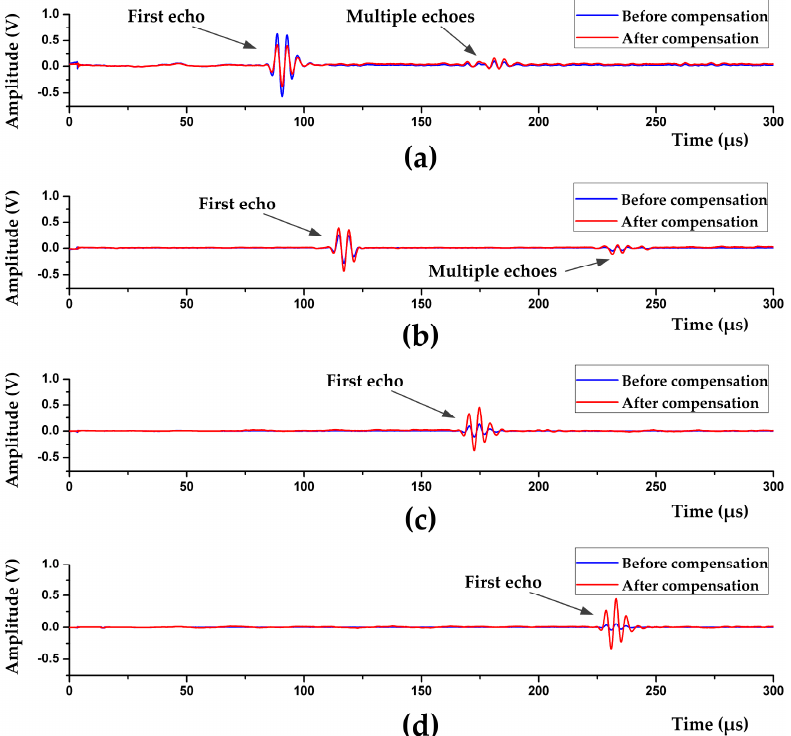
Figure 13. Waveforms of the echo signals reflected by interfaces at different distance: ( a ) 60 mm; ( b ) 80 mm; ( c ) 120 mm; and ( d ) 160 mm.